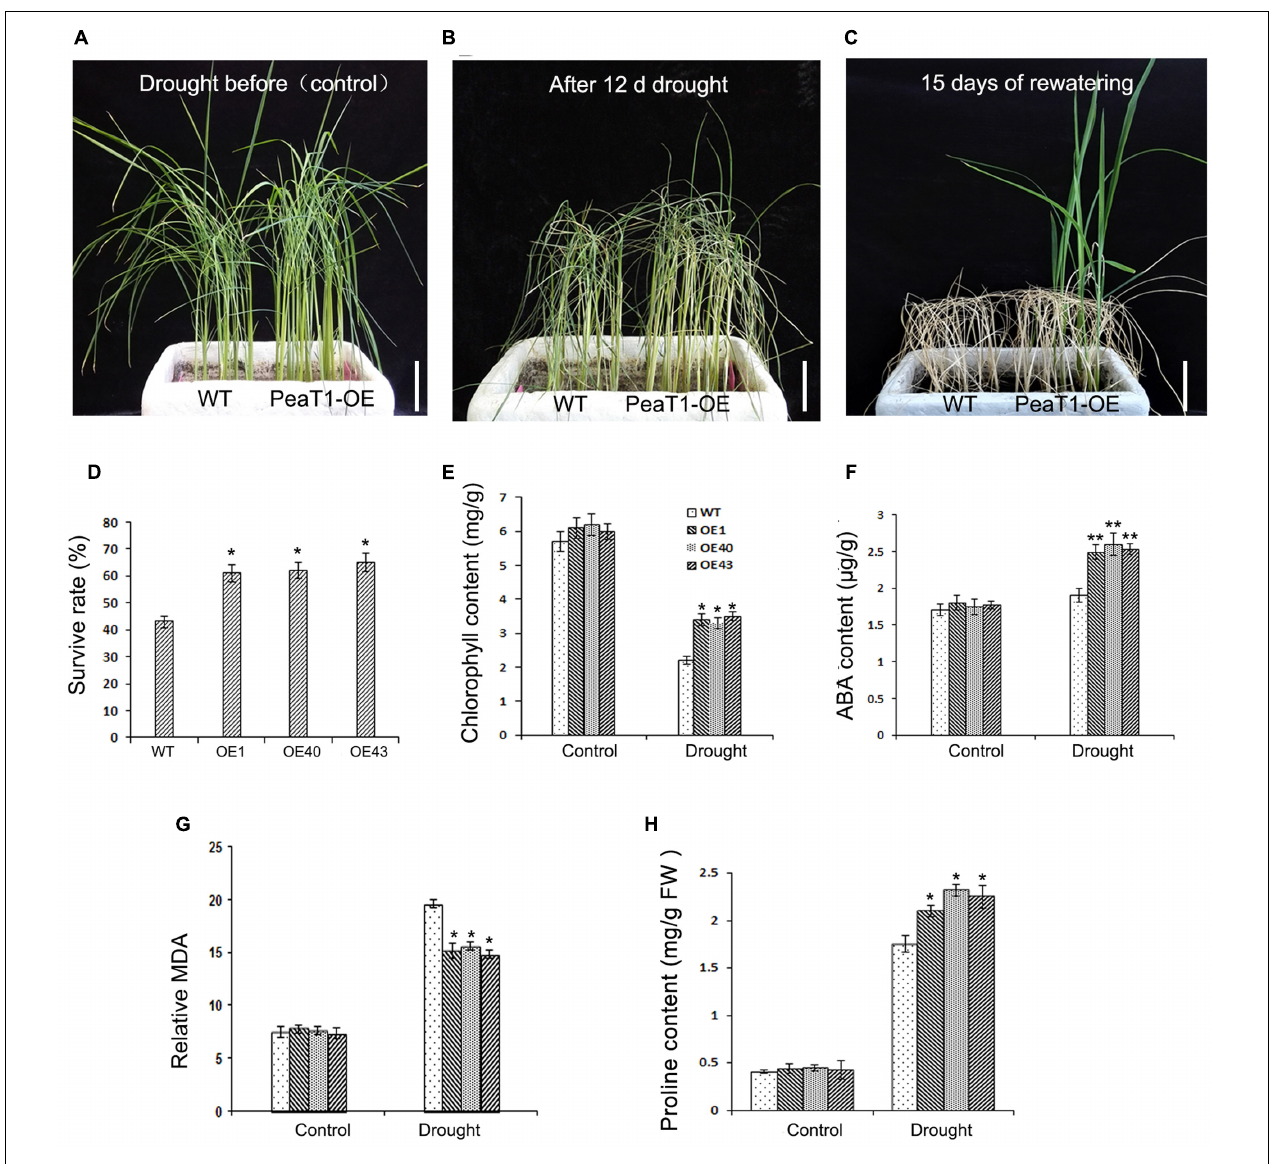
FIGURE 1 | Drought stress tolerance in wild-type (WT) and PeaT1OE lines. (A) Three-week-old seedlings. (B) Phenotypes of plants deprived of water for 12 days. (C) Phenotypes of plants 15 days after watering was resumed. (D) Chlorophyll contents of control and PeaT1OE plants, with or without the drought treatment. (E) Survival rates were calculated 15 days after watering was resumed. (F) Abscisic acid (ABA) contents of the control and PeaT1OE plants, with or without the drought treatment. (G) Malondialdehyde (MDA) contents of the control and PeaT1OE plants, with or without the drought treatment. (H) Proline contents of control and PeaT1OE plants, with or without the drought treatment. ∗ 0.01 < P < 0.05, ∗∗ P < 0.01; Bar in (A–C) is 5